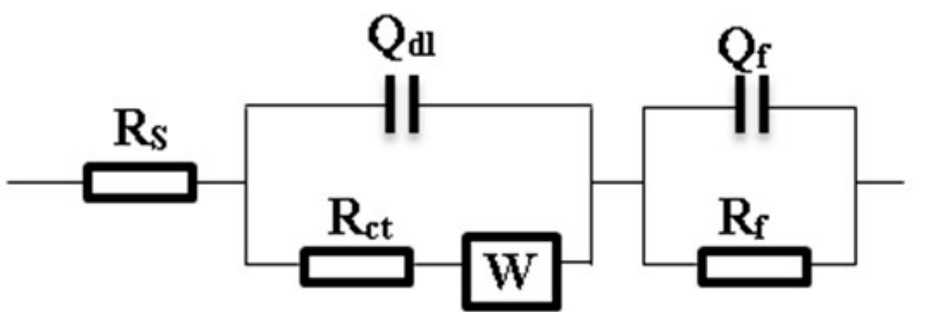
Figure 9. Equivalent circuit diagram of the AC impedance spectrum. Table 7. EIS parameters of P110 steel.